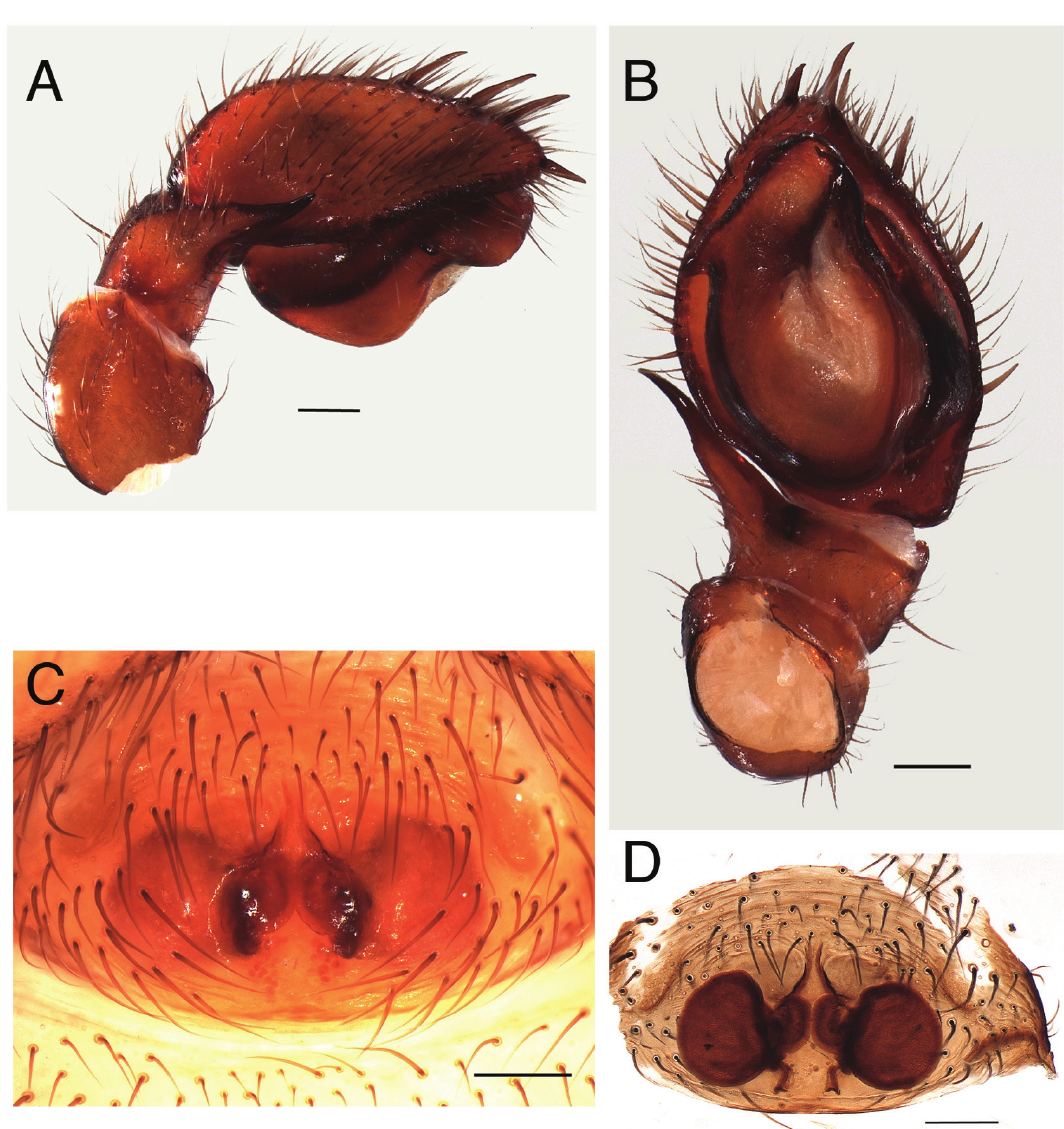
Fig. 4. Palindroma morogorom gen. et s p. nov. A–B. Paratype, ♂. C–D. Paratype, ♀. A . ♂, palp, retrolateral view. B . Idem, ventral view. C . ♀, epigyne, ventral view. D . Idem, cleared in methylsalicylate, dorsal view. Scale bars =